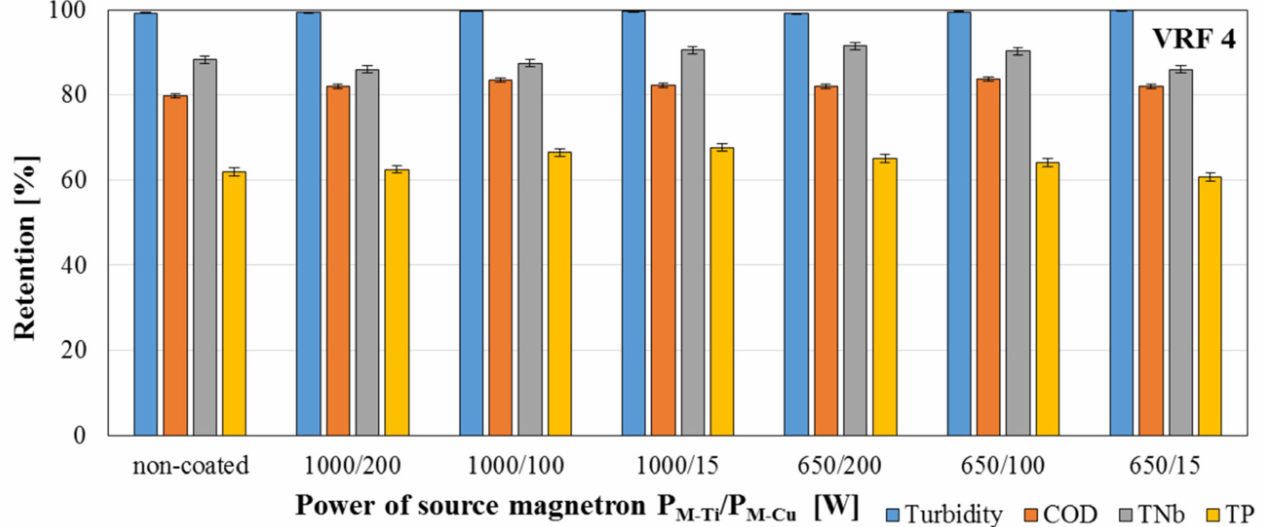
Figure 14. Retention coefficients of individual parameters of model dairy wastewater obtained after a 4-fold reduction in the volume of the feed in the filtration process using a non-coated membrane and membranes with deposited TiO 2 + CuO